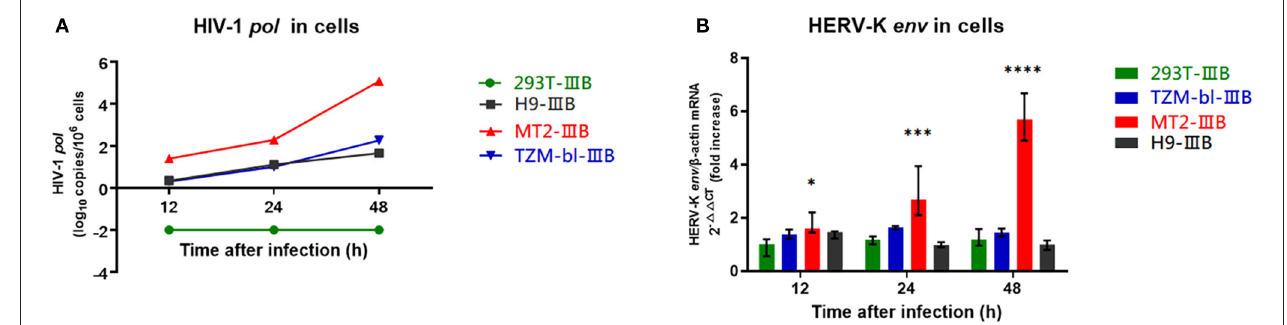
FIGURE 2 | (A) Red represents MT2 cells, blue represents TZM-bl cells, black represents H9 cells, and green represents 293T cells. The X-axis is the time of infection. The Y-axis represents log 10 of the HIV-1 pol load, and the units are indicated in the title of the Y-axis. Connecting curves are indicated. (B) Red represents MT2 cells, blue represents TZM-bl cells, black represents H9 cells, and green represents 293T cells. The X-axis is the time of infection. The Y-axis shows the fold increase in the transcription level in the HERV-K env region calculated by the 2 − 11 CT method. Standard errors for triplicate experiments are indicated. * P < 0.05, ** P < 0.01, *** P < 0.001, **** P < 0.0001. All comparisons were relative to uninfected control cells.